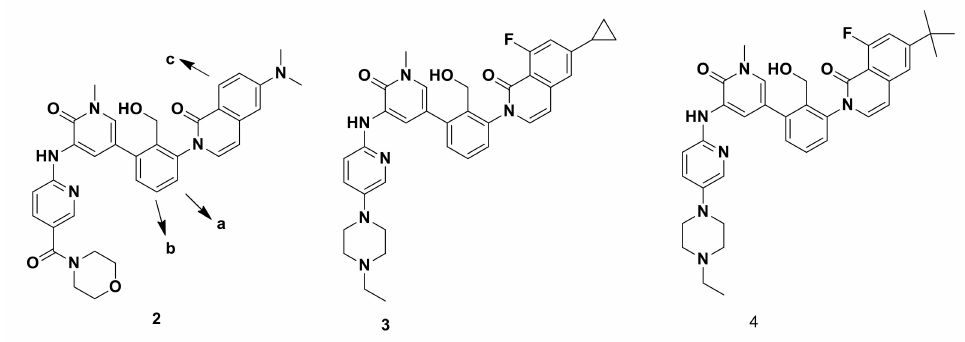
Figure 2. Selective BTK inhibitors.